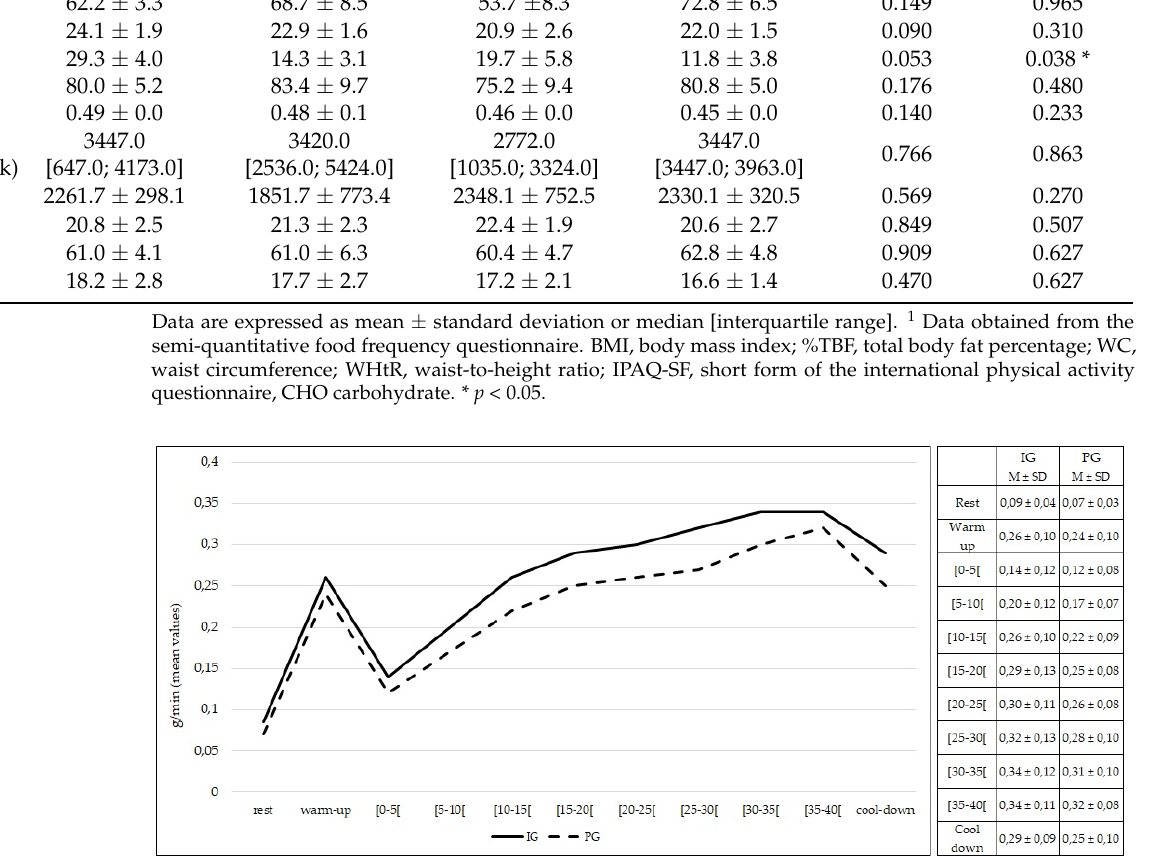
Figure 6. Lipid oxidation during rest, exercise, and cool-down in males (intervention group vs. pla- cebo group). Data are expressed as mean ± standard deviation. IG: intervention group; PG: placebo group. The rate of carbohydrate oxidation at rest was not different between the IG and PG ( p > 0.05). No differences ( p > 0.05) were found in the rate of carbohydrate oxidation during the entire 50 min of exercise between the IG and PG (Figure 7). Figure 7. Carbohydrate oxidation during rest, exercise, and cool-down in intervention group and placebo group. Data are expressed as mean ± standard deviation. IG: intervention group; PG: pla- cebo group.